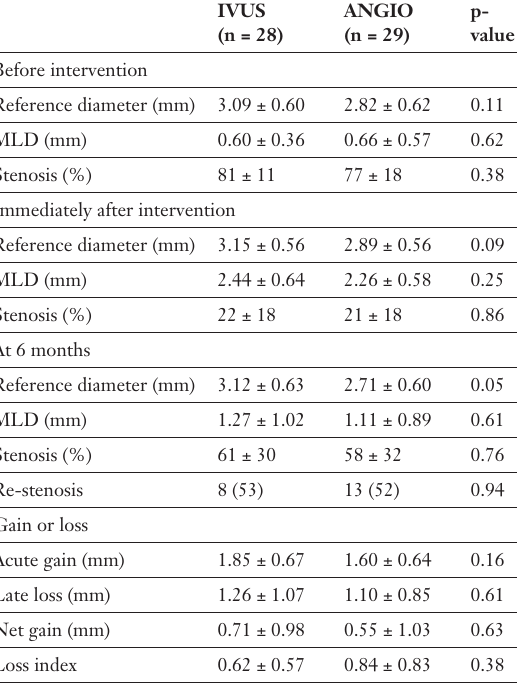
MLD denotes minimal lumen diameter of the stenotic segment. Acute gain, late loss, net gain and loss index are defined in the Methods section. Data are expressed as mean ± SD